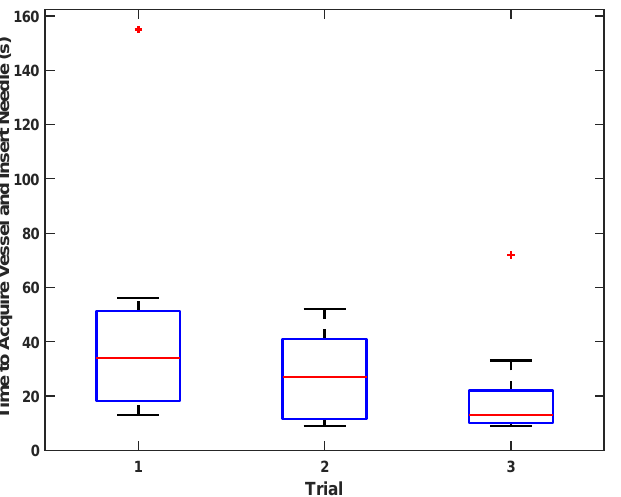
Figure 9. Times to acquire vessel and inject needle in phantom. Box-and-whiskers format displays median, interquartile range (IQR, box), ± 1.5 IQR (whiskers), and individual data points outside of whiskers.